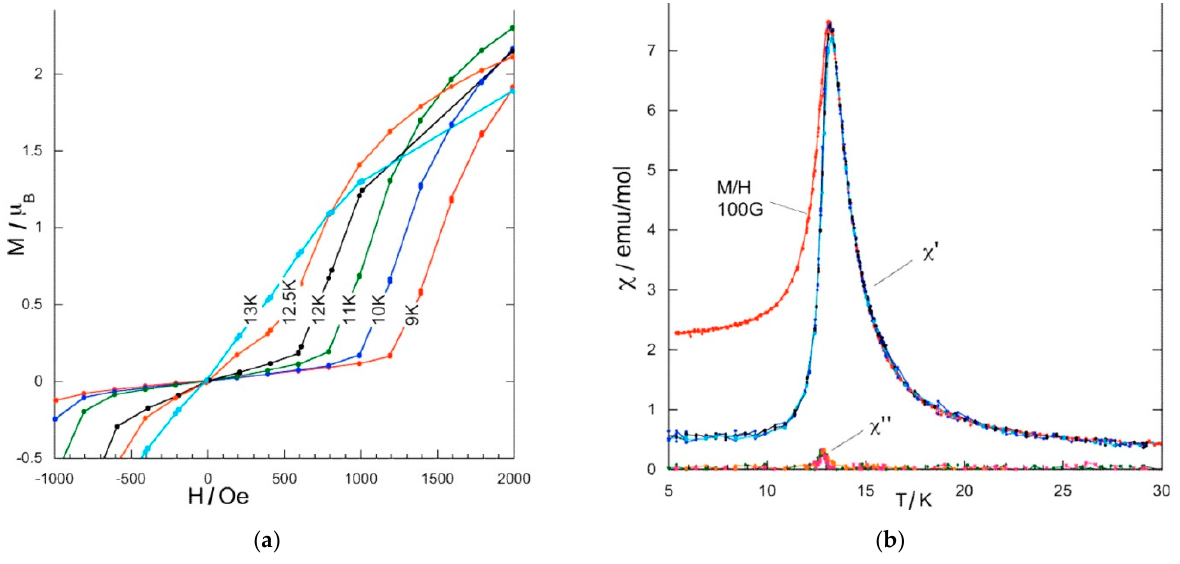
Figure 8. Magnetic data for a powder sample of 11: ( a ) M vs. H plots at different temperatures closed to T N ; ( b ) the temperature dependencies of dc susceptibility at 100 Oe and the χ ’ and χ ’’ parts of the ac susceptibility obtained with H dc = 1 Oe at 0.57, 5.7, and 57 Hz. Reproduced with permission from ref. [44]. © 2022 American Chemical Society.